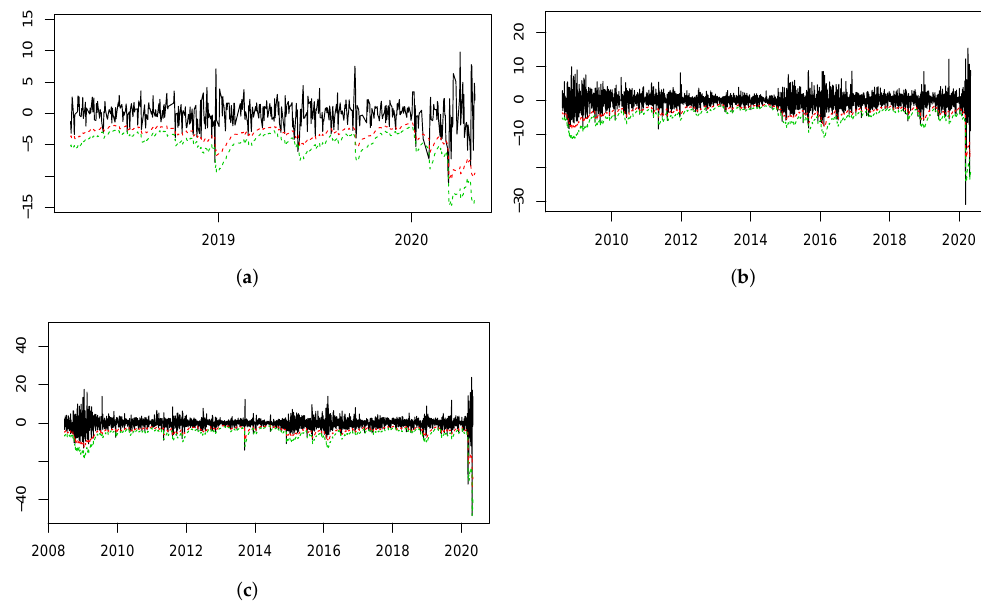
Figure 4. Value-at-Risk analyses. ( a ) INE. ( b ) BRE. ( c ) WTI. Note: this figure presents the Value-at- Risk results of INE, BRE and WTI via the TZD-GARCH model. The sample ranges from 2018 to 2020 for INE, and from 2008 to 2020 for BRE and WTI. Dashed red and dashed green curves are the fitted 95% and 99% Value-at-Risk,